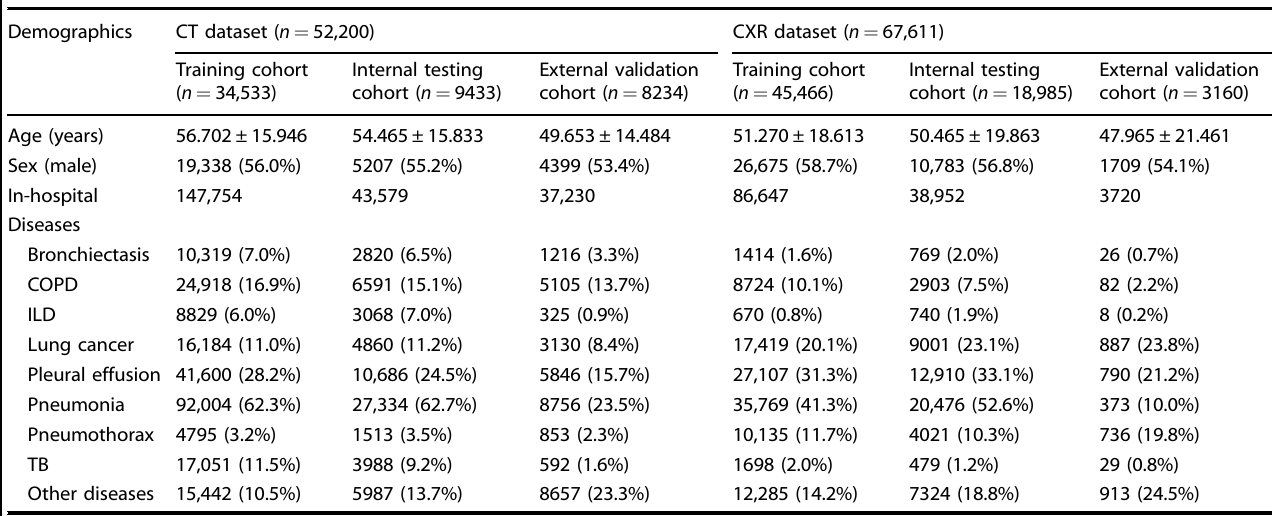
Table 1. Summary of training, internal testing and external validation datasets.